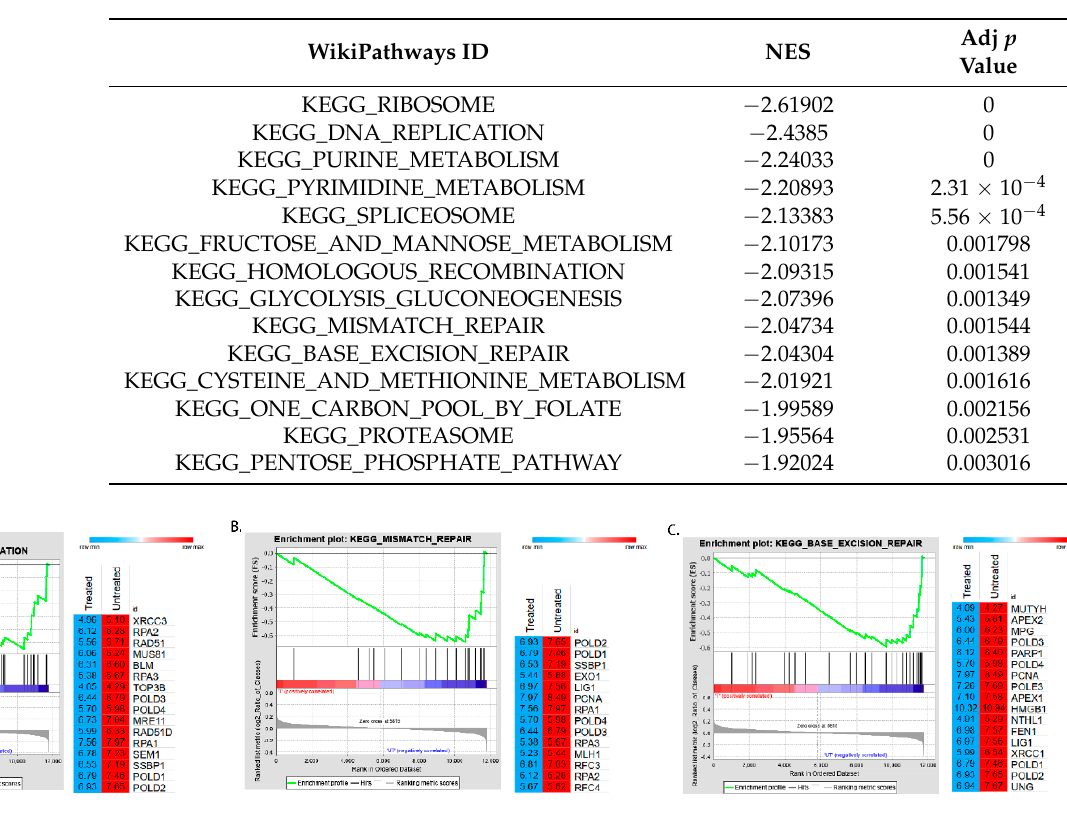
Table 2. A list of the top 13 KEGG pathways found enriched in CPT-CEF-treated colon cancer cells. Gene set enrichment analysis was performed using the KEGG database as a reference (adj p < 0.05). NES, normalized enrichment score.